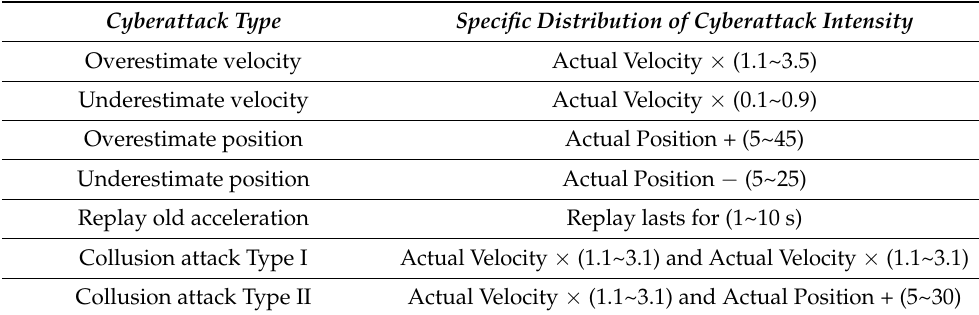
Table 5. Linearly distributed cyberattack intensity in different cyberattacks